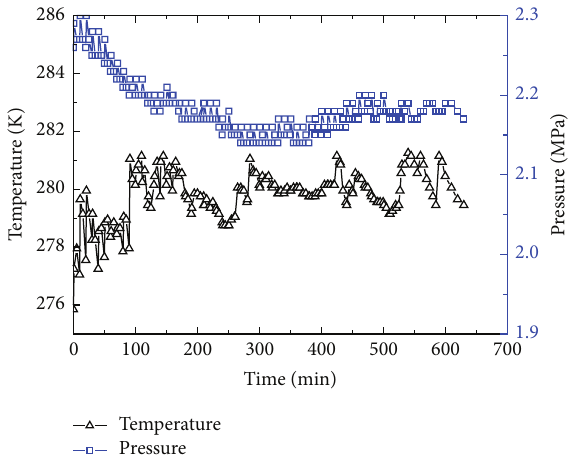
Figure 4: Temperature and pressure of hydrate formation in THF solution.